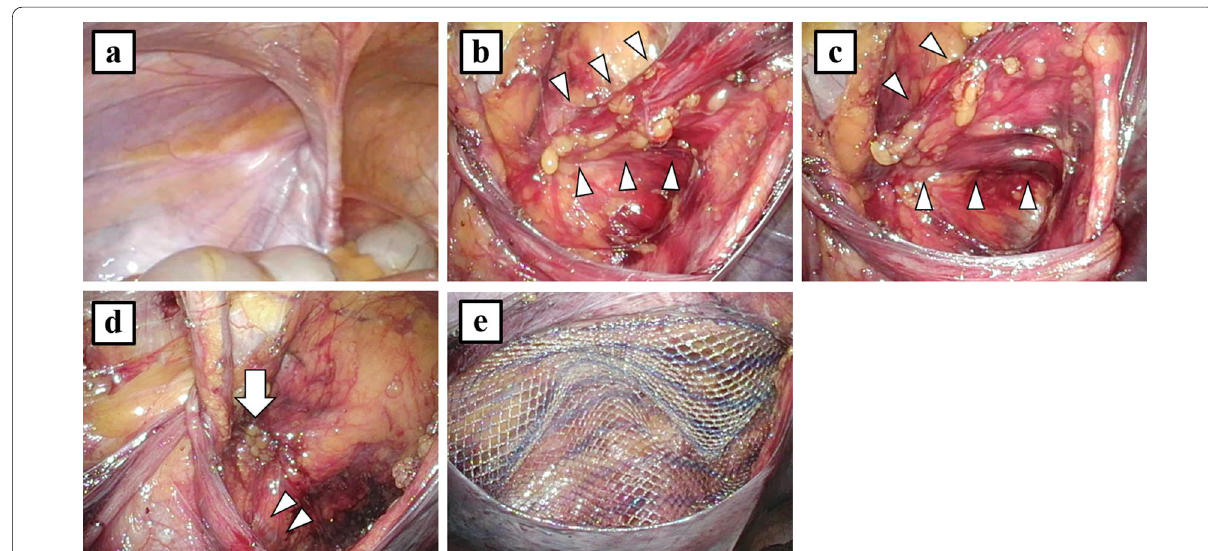
Fig. 2 Operative findings. a Laparoscopy and intraperitoneal observation revealed a left indirect inguinal hernia. There were no other peritoneal indentations. b A mass covered with the vesicohypogastric fascia (arrowheads) was pulled into the femoral ring in the preperitoneal space. c The mass was confirmed to be a portion of the bladder (arrowheads); the mass expanded when saline was injected through the urinary catheter. d The protruding bladder was reduced carefully from the femoral ring (arrow). An aberrant obturator artery was observed (arrowheads). e The left myopectineal orifice was repaired with a